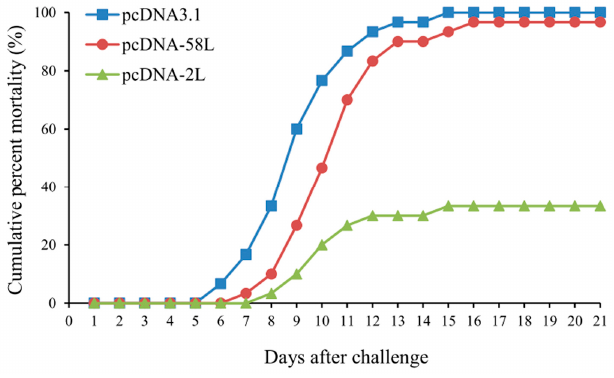
Figure 5. Cumulative mortality curves of vaccinated Chinese giant salamanders upon challenge with ADRV. The vaccinated Chinese giant salamanders were intraperitoneally injected with ADRV and monitored daily for mortality over a 21-day observation period. Table 1. Cumulative mortality and relative percentage survival (RPS) of vaccinated Chinese giant salamanders infected with ADRV.